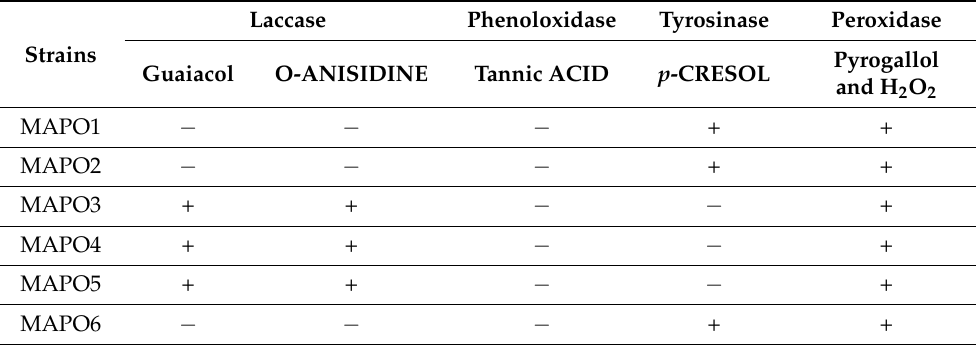
Table 5. Qualitative assay for lignin-degrading enzymes detection on MEA plates. Oxidative activity was determined on the 7th day of cultivation by adding the specific substrate for each